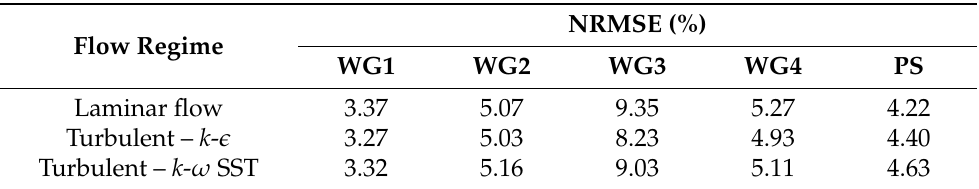
Table 6. NRMSE values for numerical wave gauges and pressure